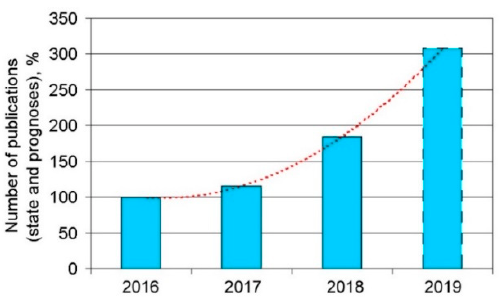
Figure 1. Increasing number of research articles containing expert knowledge on new technologies and involving investigations into single-track features in Selective Laser Melting (SLM)/LPBF processing.